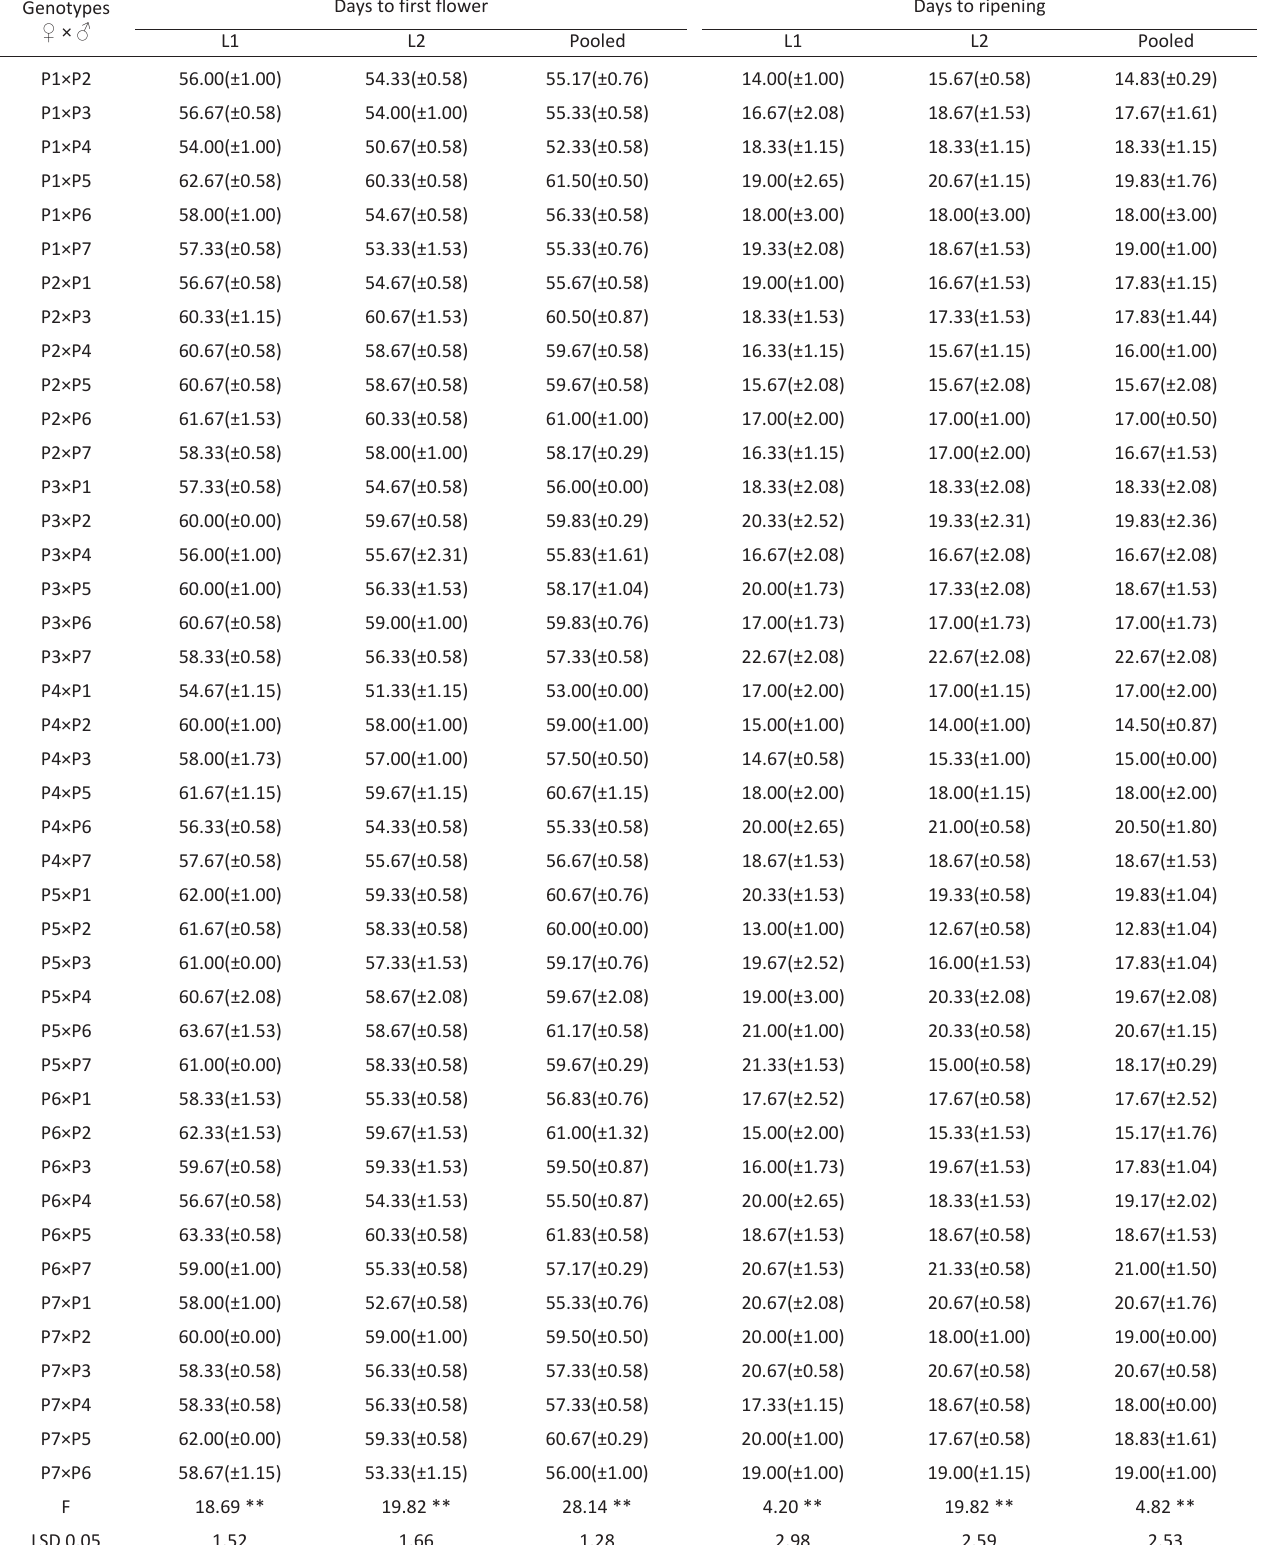
Table 5 - Means values and standard deviation for yield components and earliness of F1 hybrids developed via 7×7 diallel cross over two light